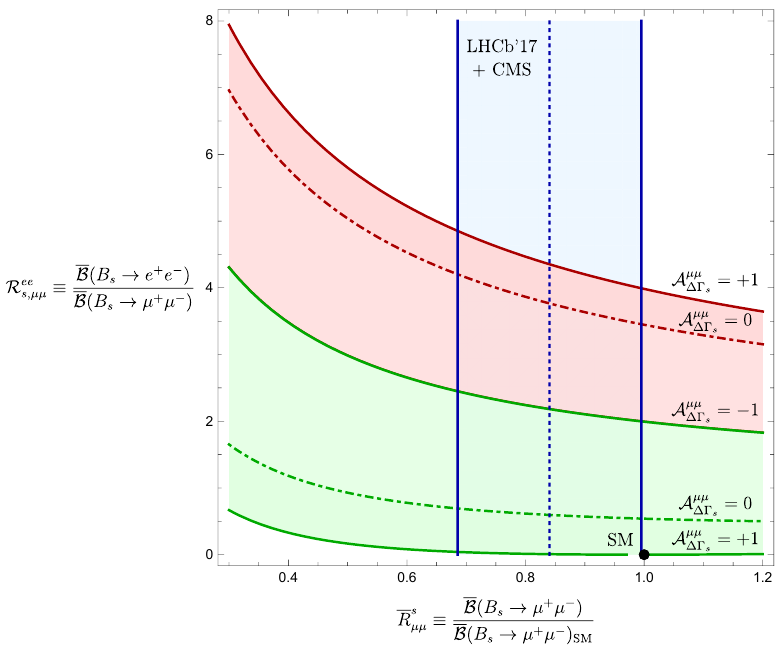
ee as a function of (cid:22) R s in the (cid:13)avour- s;(cid:22)(cid:22) (cid:22)(cid:22) R (cid:22)(cid:22) . As in (cid:12)gure 6, (cid:1)(cid:0) s A , respectively. (cid:22)(cid:22)